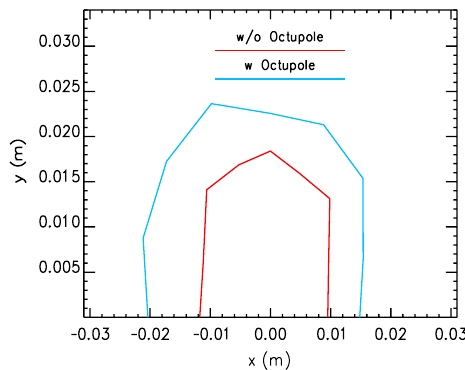
FIG. 17. Dynamic aperture in the ( y (cid:1) x ) space at the entrance into one of the CCBs for the on-momentum particle without (red) and with (blue) the octupole compensation of the 1st-order amplitude-dependent tune